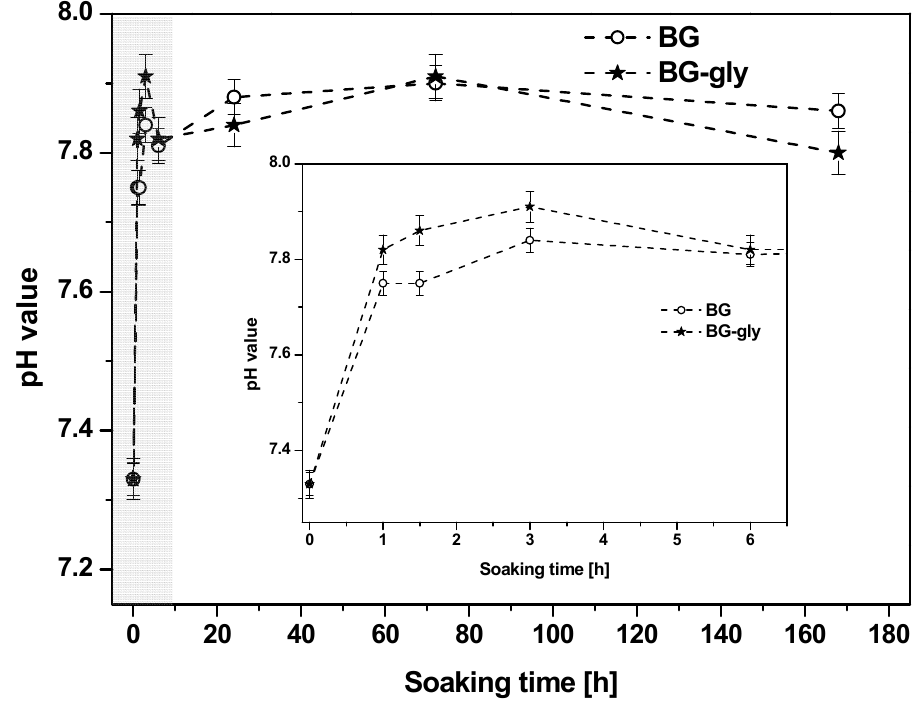
Figure 1. Evolution of pH value in simulated body fluid (SBF) as a function of the immersion time for bioglass (BG) and bioglass-glycerol (BG-gly) paste; the inset represents the magnification of the grayish area of the plot.